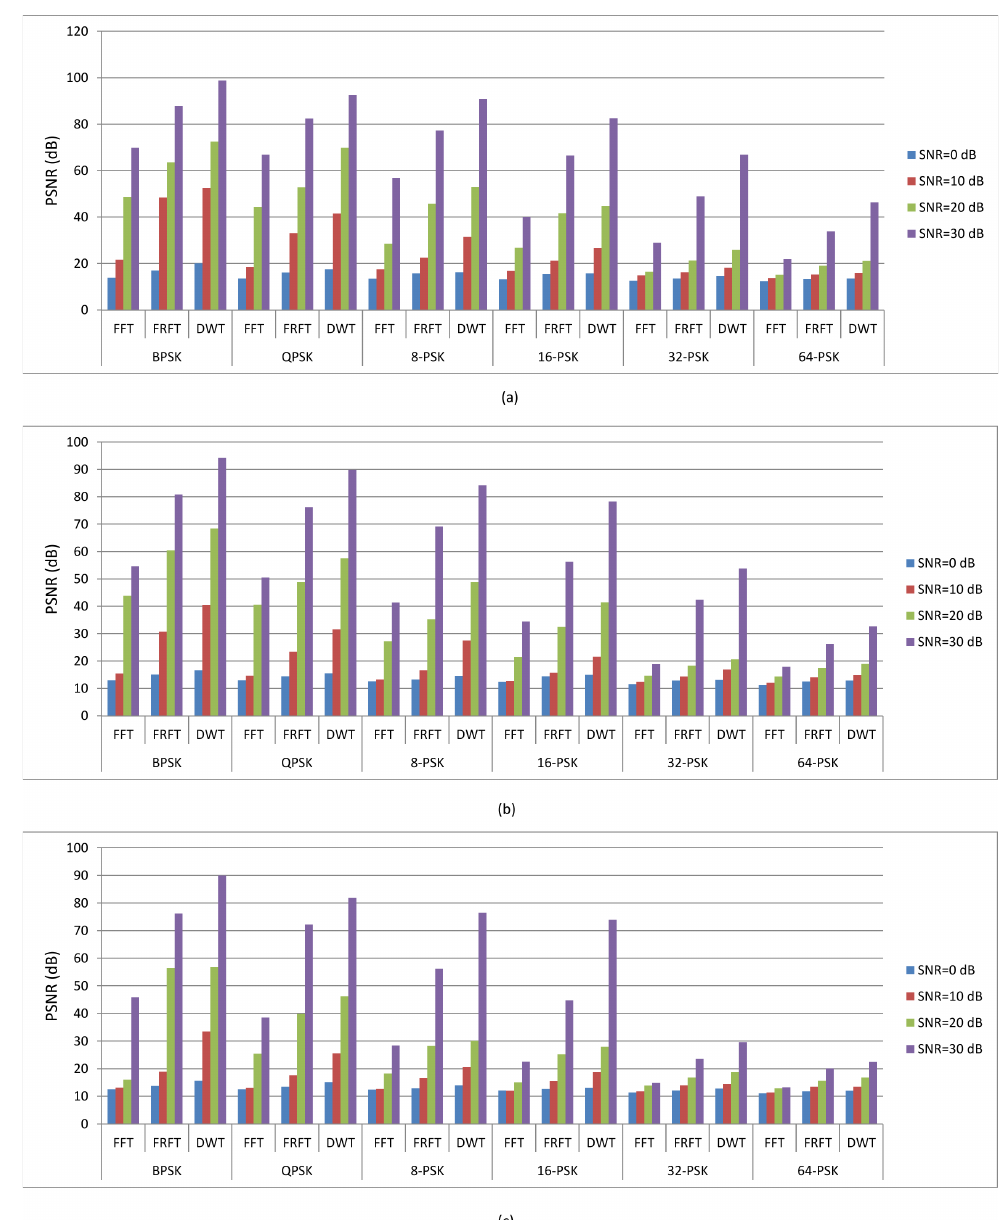
Figure 22. PSNR variations for Massive MIMO incorporated FFT-OFDM, FRFT-OFDM and DWT- OFDM for various modulation levels and number of users over Rayleigh Channel. ( a ) n = 10; ( b ) n = 20; ( c ) n =